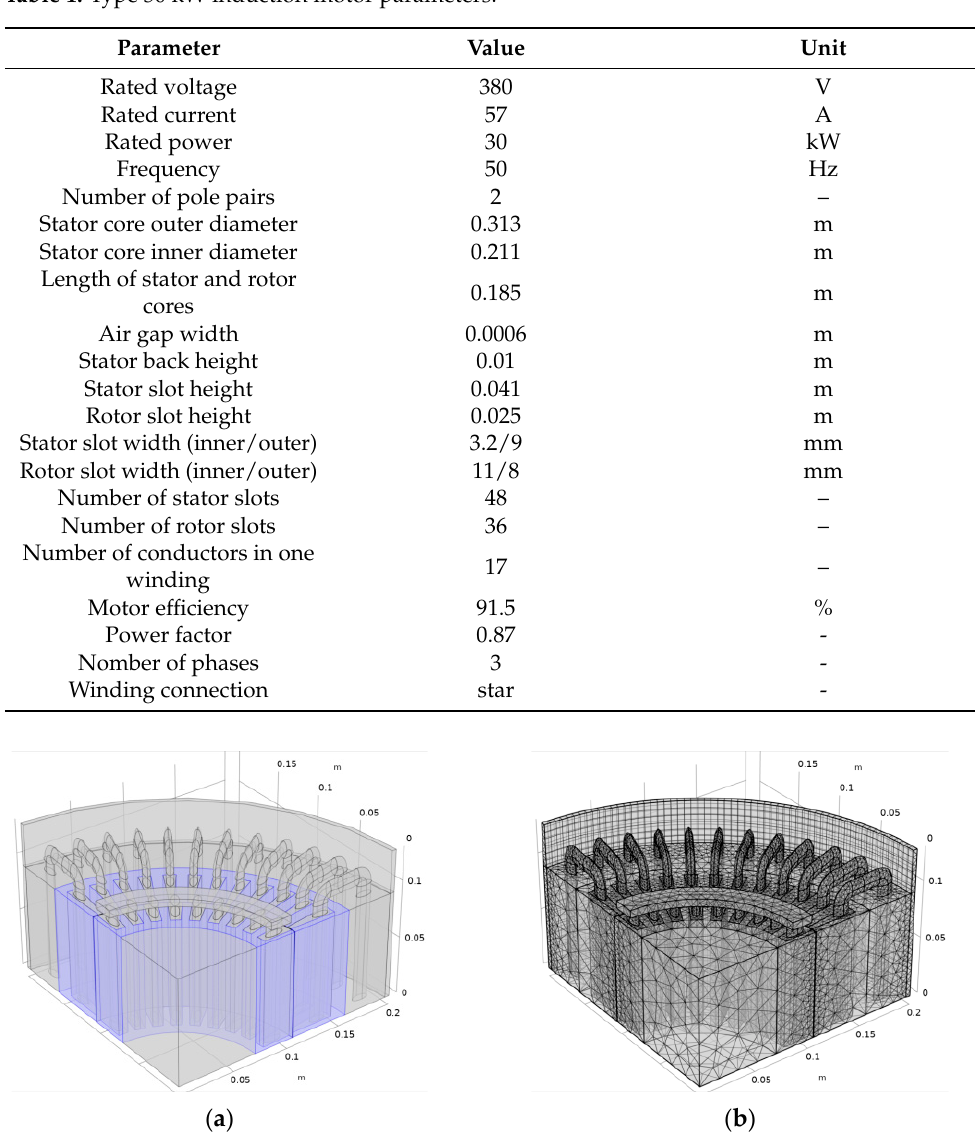
Table 1. Type 30 kW induction motor parameters.